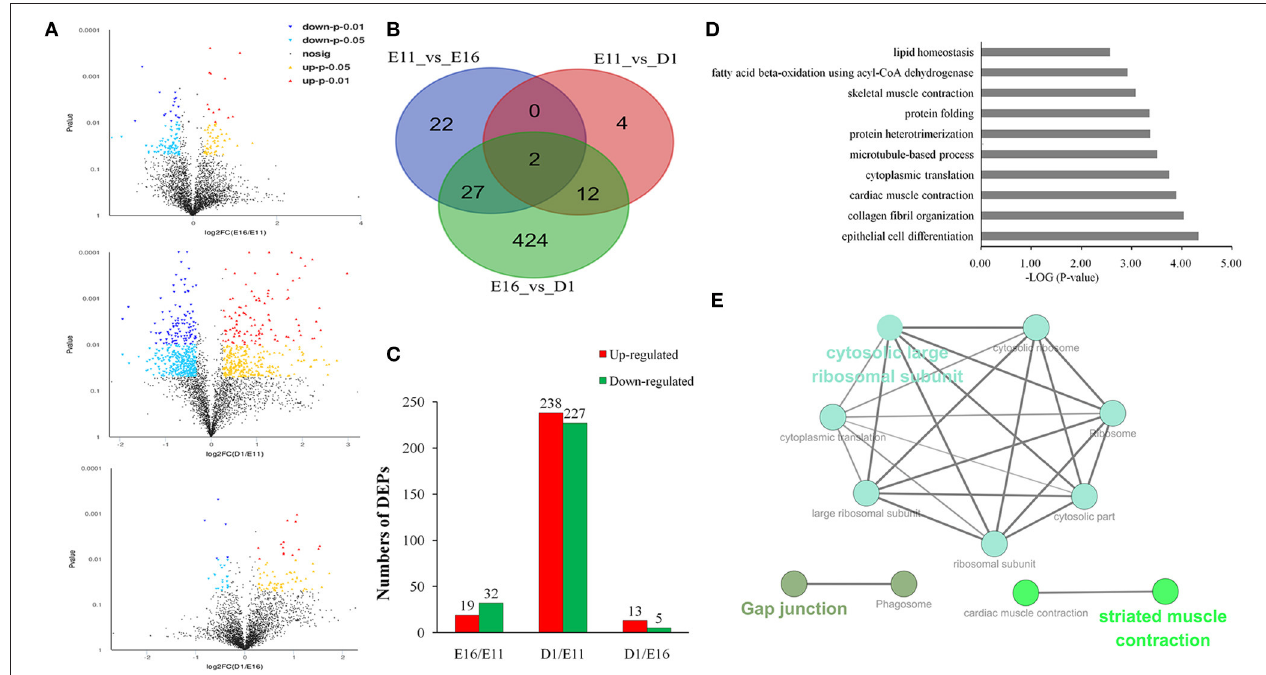
FIGURE 2 | Differentially expressed proteins in three different development stages of embryonic muscle. (A) Volcano plots of differentially expressed proteins in three comparisons: E11 vs. E16, E11 vs. D1, and E16 vs. D1. (B) Venn diagrams of differentially expressed proteins ( n = 491; P < 0.05, fold change > 1.5 or < 0.66). (C) Number of differentially expressed proteins in three comparisons: E11 vs. E16, E11 vs. D1, and E16 vs. D1. (D) The top 10 GO enrichment terms for differentially expressed proteins. (E) The 57 proteins in the top 10 biological processes were analysis using ClueGO of Cytoscape software.